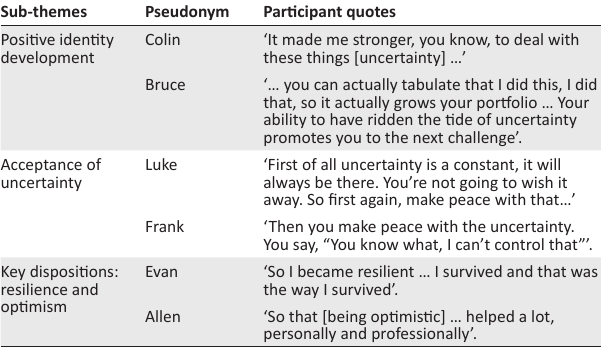
TABLE 3: Development of mental